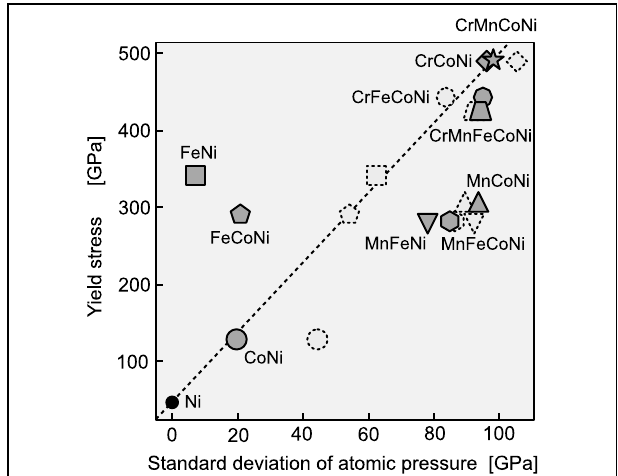
FIGURE 2 | Experimental yield stress versus standard deviation of atomic pressure in various fcc random alloys. The experimental yield stress data were obtained from the friction stress (without its athermal portion) estimated at 0 K in Wu et al. (2014). For Ni, the Peierls friction stress is shown as the zero-temperature stress value, as in Oh et al. (2019). The broken symbols represent data obtained in Oh et al. (2019). The broken line connecting Ni and CrMnFeCoNi is an eye guide.